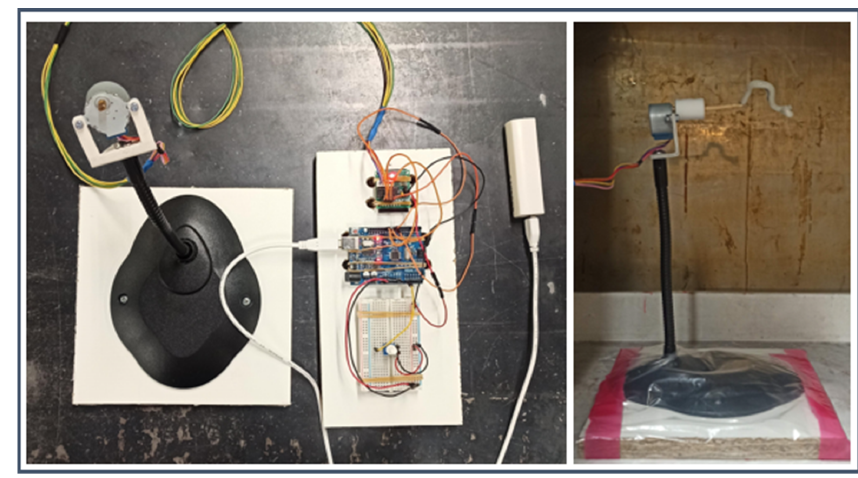
Figure 5. Set-up to rotate the models inside the heating chamber.